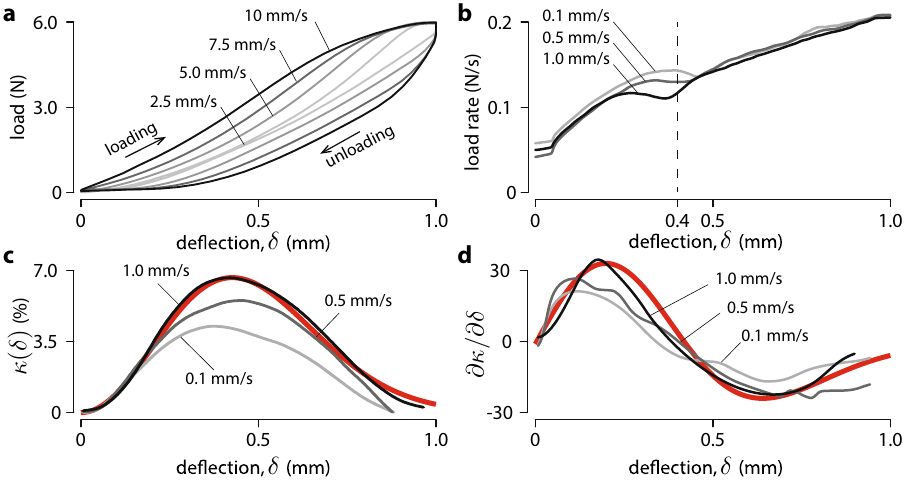
Figure 3. Large displacement analysis. ( a ) Rate dependent hysteresis. ( b ) Non-monotonic relationship between load-rate and deflection. ( c ) Relationship between the variation of resistance and deflection. The red line shows the prediction of the model (1). ( d ) Relationship between the rate of change of resistance and the deflection. The red line shows the prediction of the model